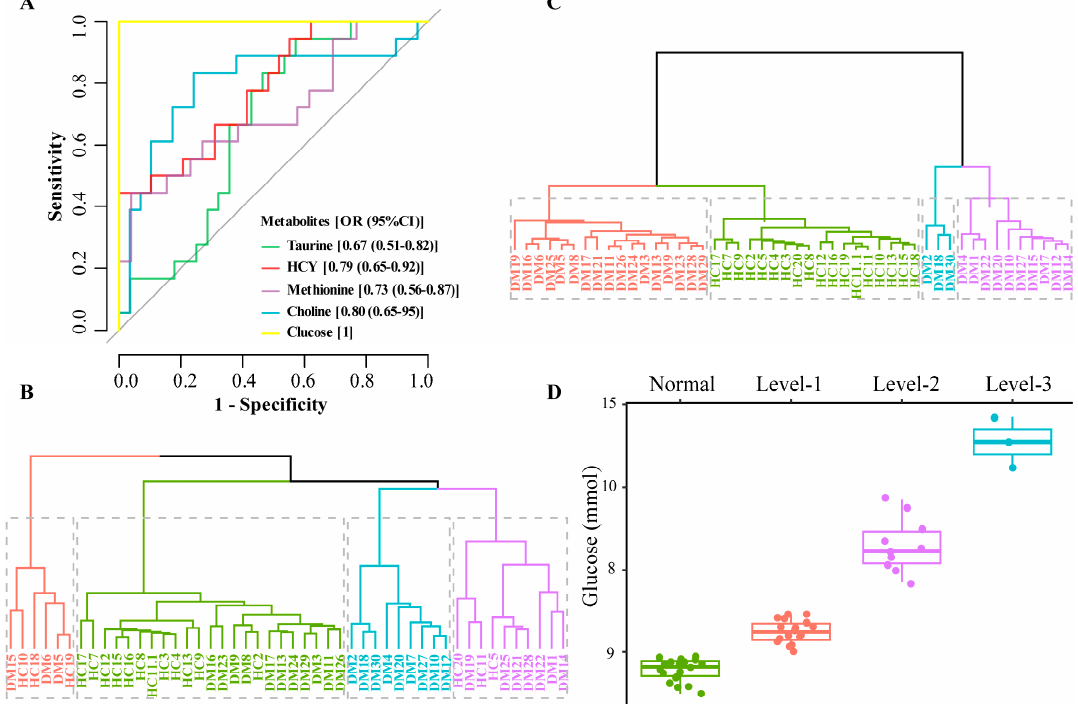
Figure 5. ROC analysis, k-means cluster analysis, and blood glucose distribution corresponding to the clustering results (( A ). ROC analysis, ( B ). Sample clustering results using all 13 metabolites; 4 clusters (colored and boxed) were identified and HC samples cannot be distinguished from DM samples, ( C ). Sample clustering results based on 4 metabolites; 4 clusters (colored and boxed) were identified and HC samples are in one category, ( D ). Clustering results corresponding to blood glucose distribution).